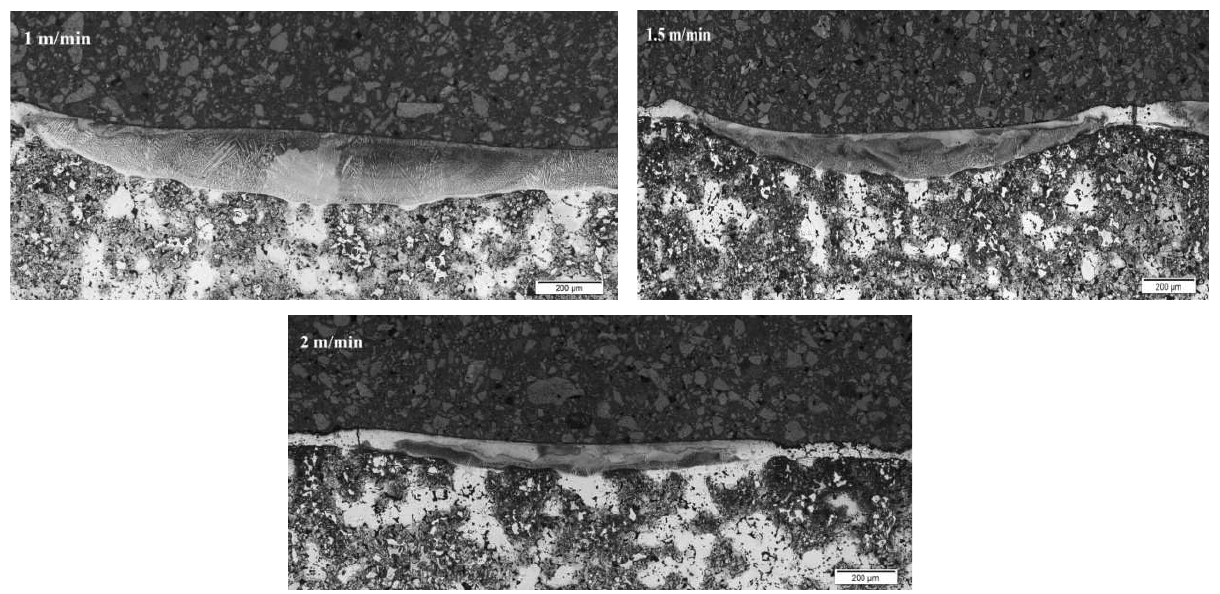
Figure 7. Cross-section of the entire alloyed zone for sample 1.